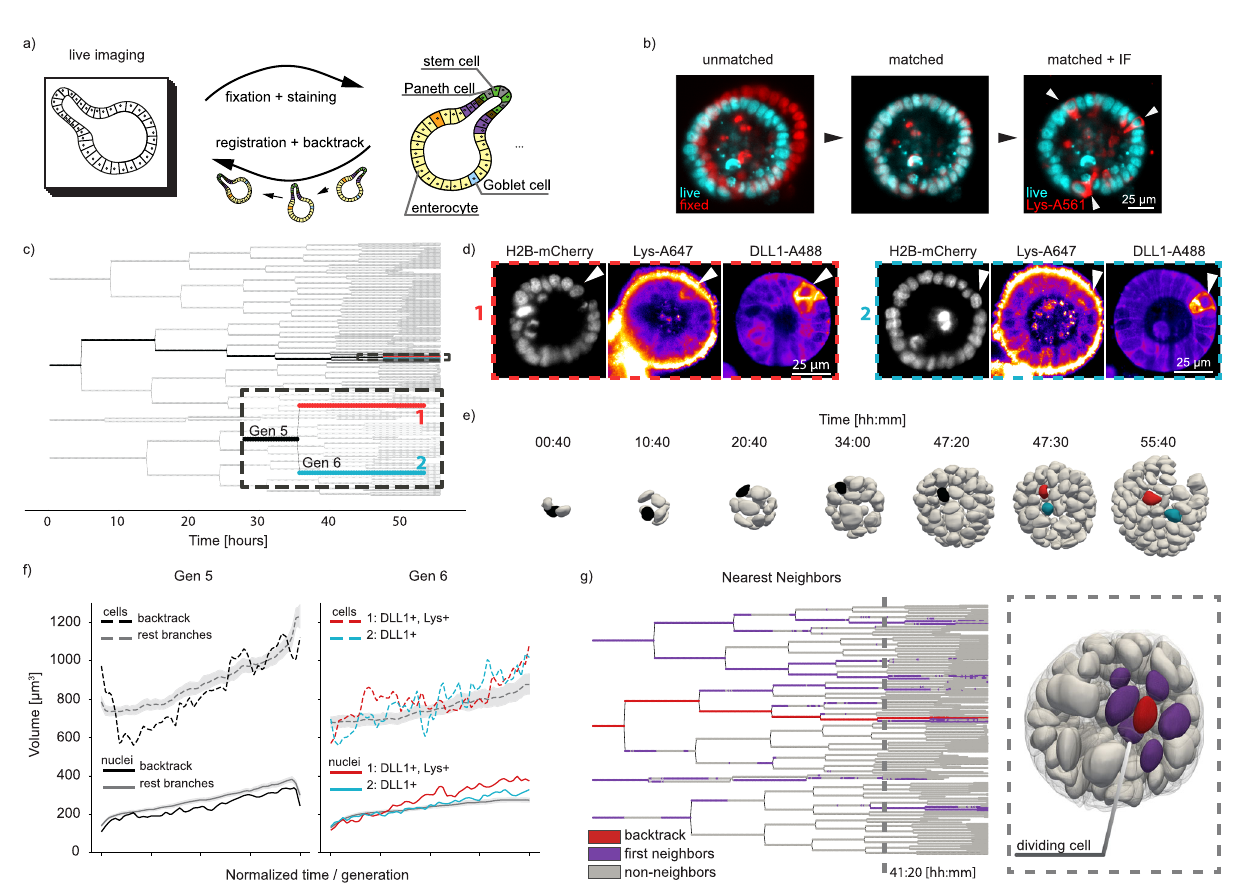
Fig.4|Fixationandbacktrackingafterlive-imaging.a Fixationandbacktracking strategyforlight-sheetimagingoforganoidgrowth(shownrecording007). b After fi xationaregistrationstepmaybeneededtooverlapthe fi xednucleiwiththenuclei asshowninthelasttimepointofthetimelapse.Left:midplaneofrawdatafromlast time-point H2B-mCherry recording (cyan) against same plane after fi xation (red). Center: registration maps the fi xed volume into the last time-point